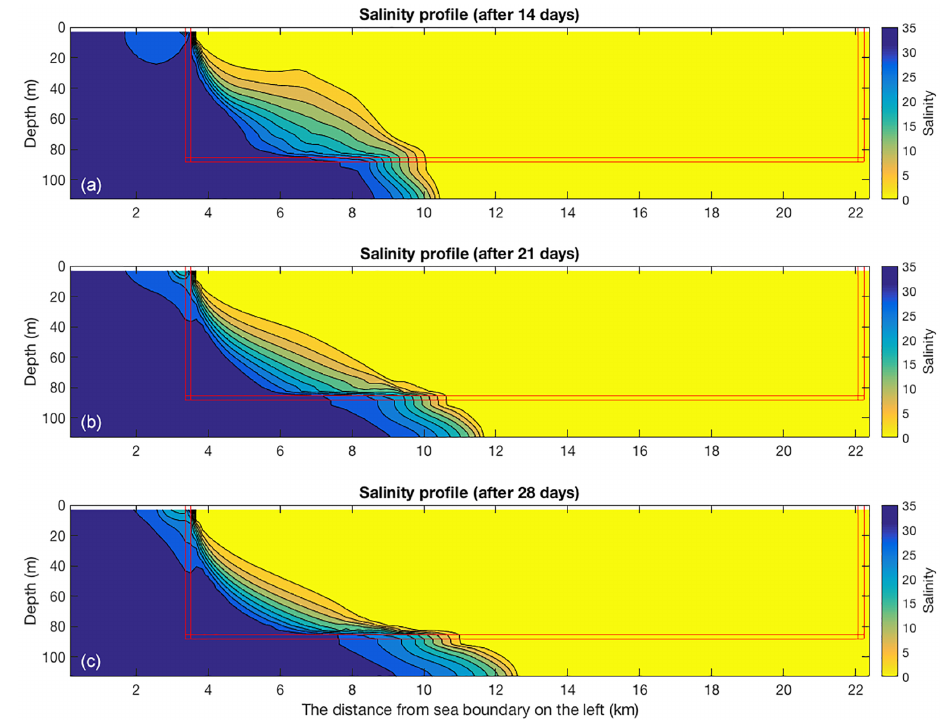
Figure 15. Salinity simulation of the maximum seawater intrusion benchmark case (35PSU, 0.0m at the submarine spring) with extended simulation time during a low rainfall period: (a) 14-day simulation period; (b) 21-day simulation period; (c) 28-day simulation period (from top to